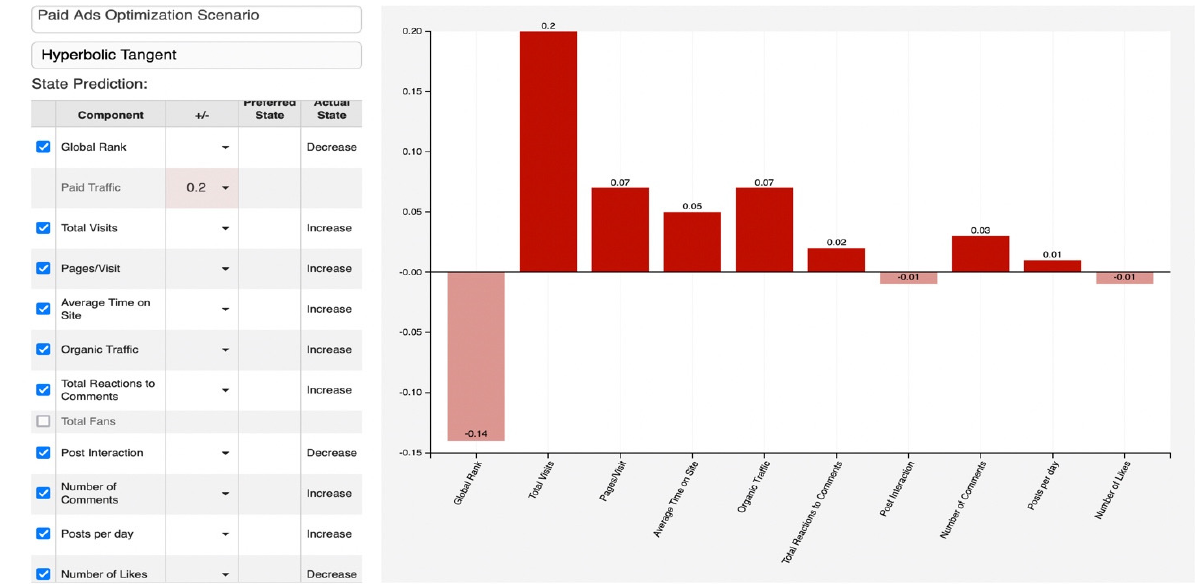
Figure 2. Paid Advertisement optimization scenario.